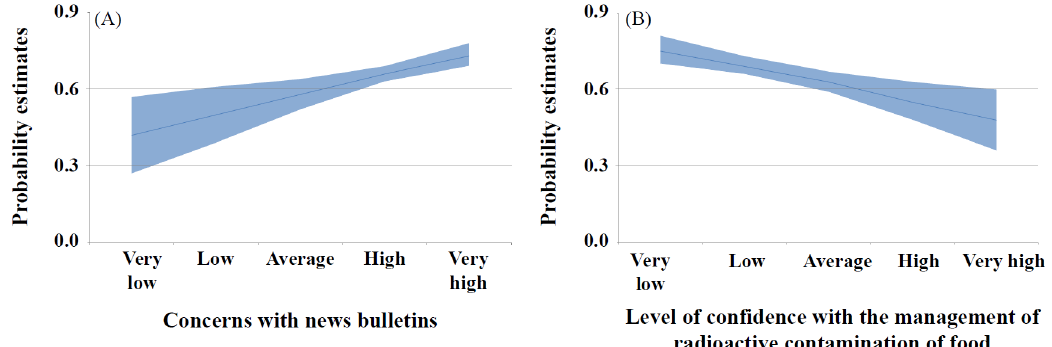
Fig 1. Changes in seafood purchase frequencies after the Fukushima accident per concerns with news bulletins and the level of confidence in the management of radioactive contamination of food. The x-axis denotes the concernswith news bulletins(A) and the level of confidencein the management of radioactivecontamination of food (B). The y-axis denotes probabilityestimates with the decreasein seafood purchasefrequencies after adjustingfor significant variables in the multivariate model. The 95% confidenceinterval on the estimates is shown in blue shading. Higher concernswith news bulletinsincreasedthe probability of not purchasing seafood(A), and the higher the trust in management of radioactive contamination of food, the lower the probabilityof